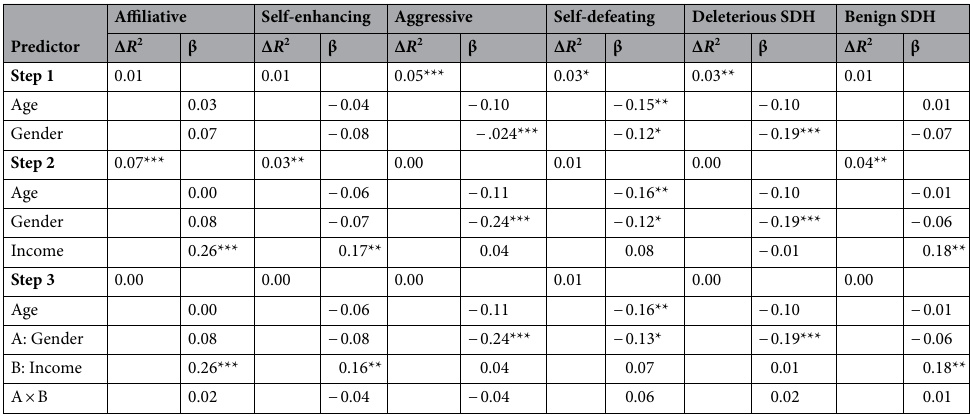
Table 2. Hierarchical multiple regression analysis to predict six types of humor. N = 344. * p < 0.05. ** p < 0.01. *** p < 0.001.